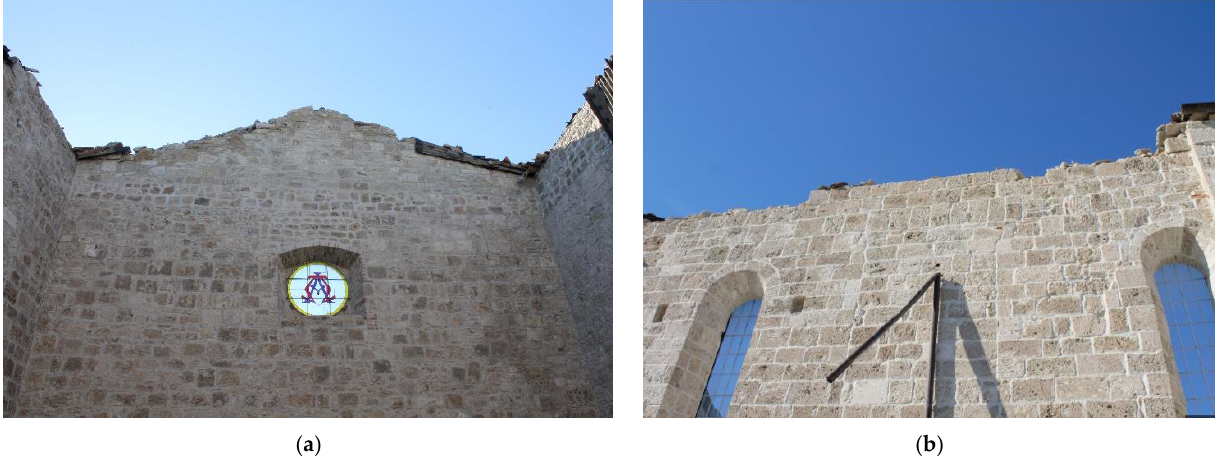
Figure 25. Limited damages and loss of usability in the Abbey in Montesanto (C25): ( a ) absence of damage in the façade and roof collapse; ( b ) absence of damage in the lateral wall.